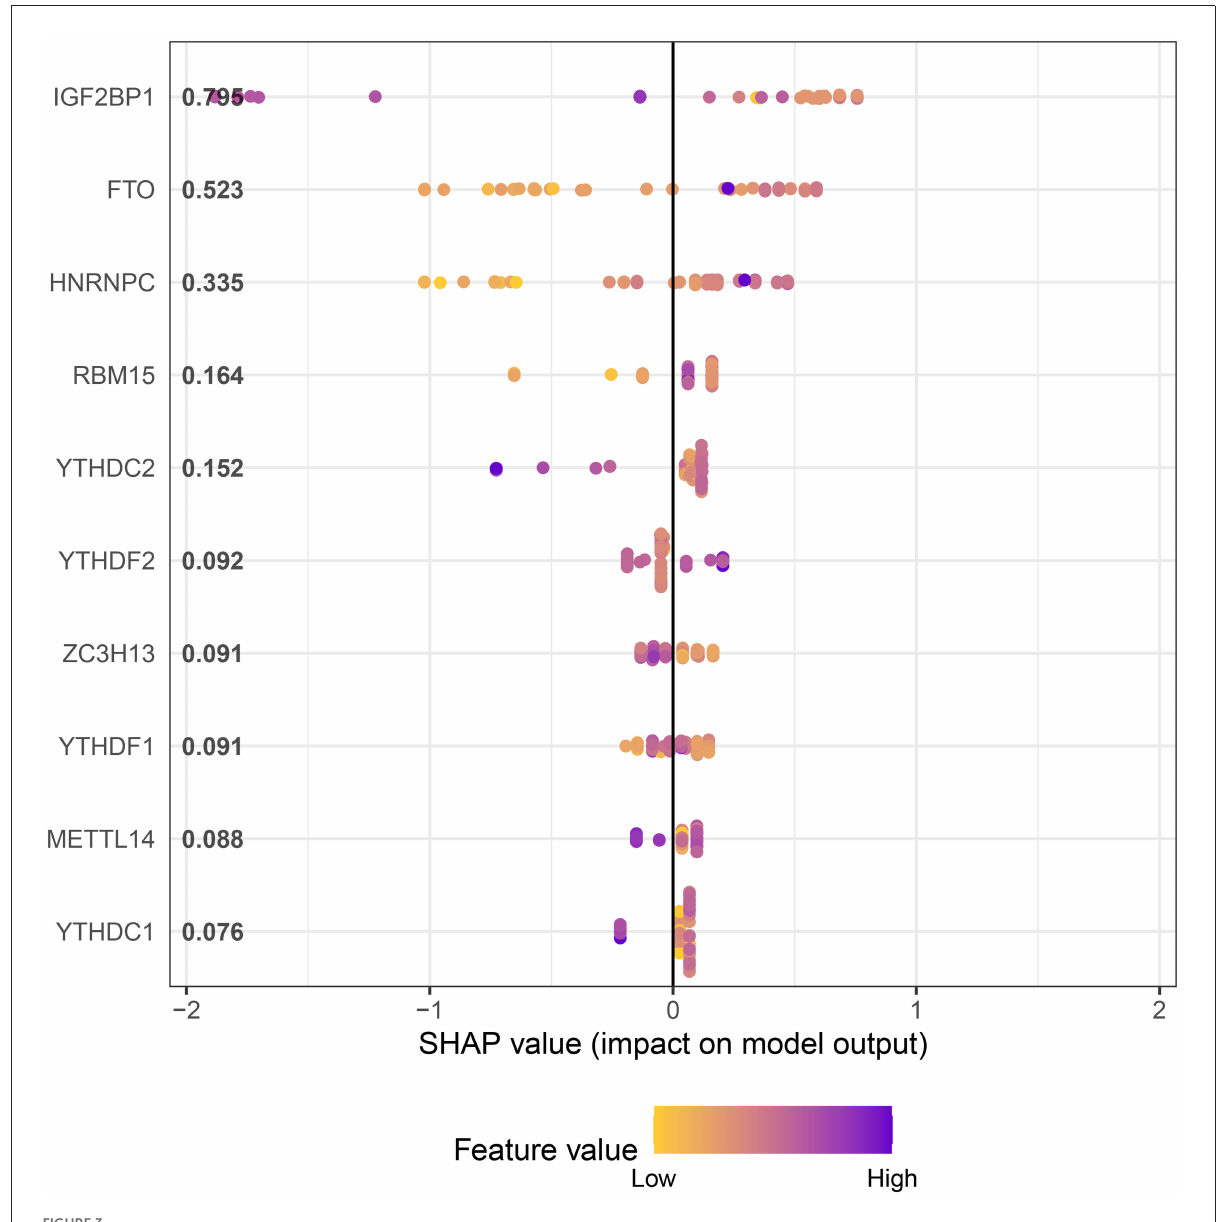
FIGURE3 XGboost screens for m6A genes with a significant impact on AD.